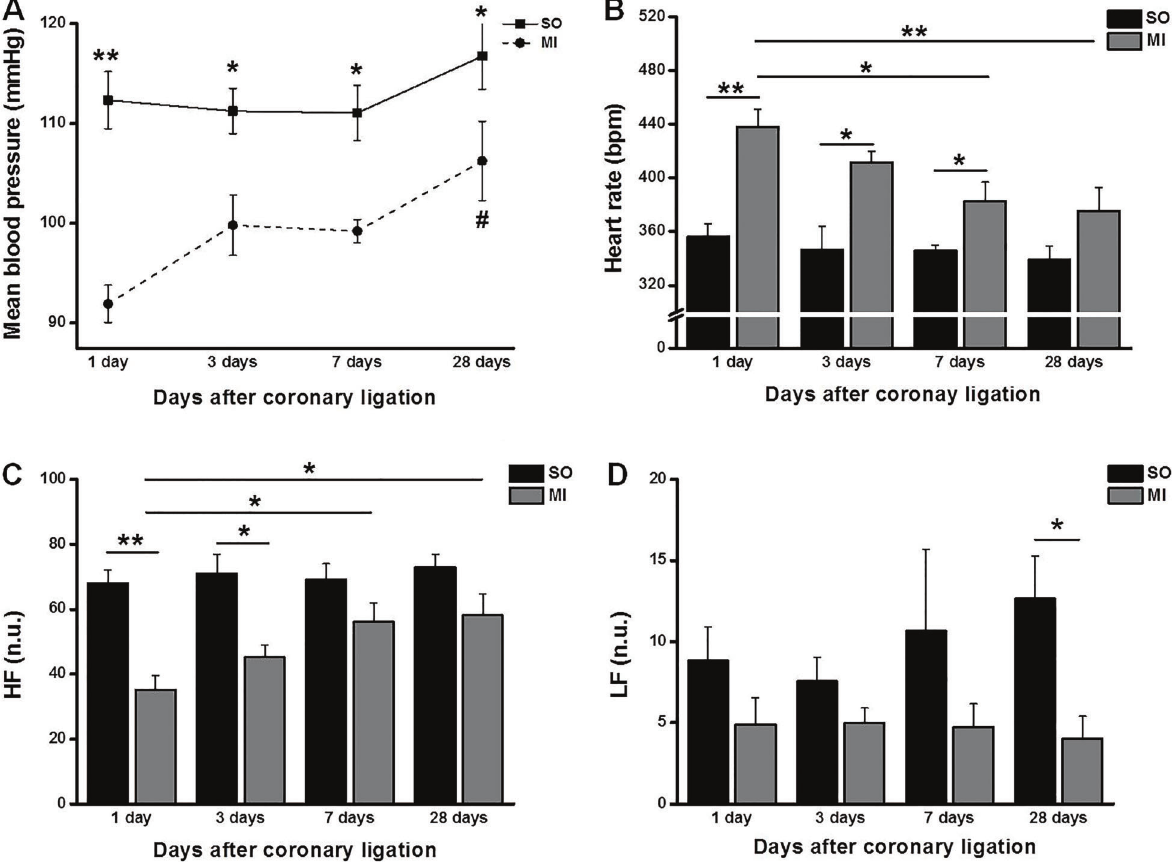
Figure 1. Mean blood pressure ( A ), heart rate ( B ) and high frequency (HF) ( C ), low frequency (LF) ( D ) components in normalized units (n.u.) of heart rate variability in sham operated (SO) and infarcted (MI) rats studied at different times after surgery. Results are reported as means ± SE. Data were compared by two-way ANOVA and multiple comparisons were performed by the Fisher ’ s post hoc test. *P o 0.05; **P o 0.01; # P o 0.05 SO-28 vs